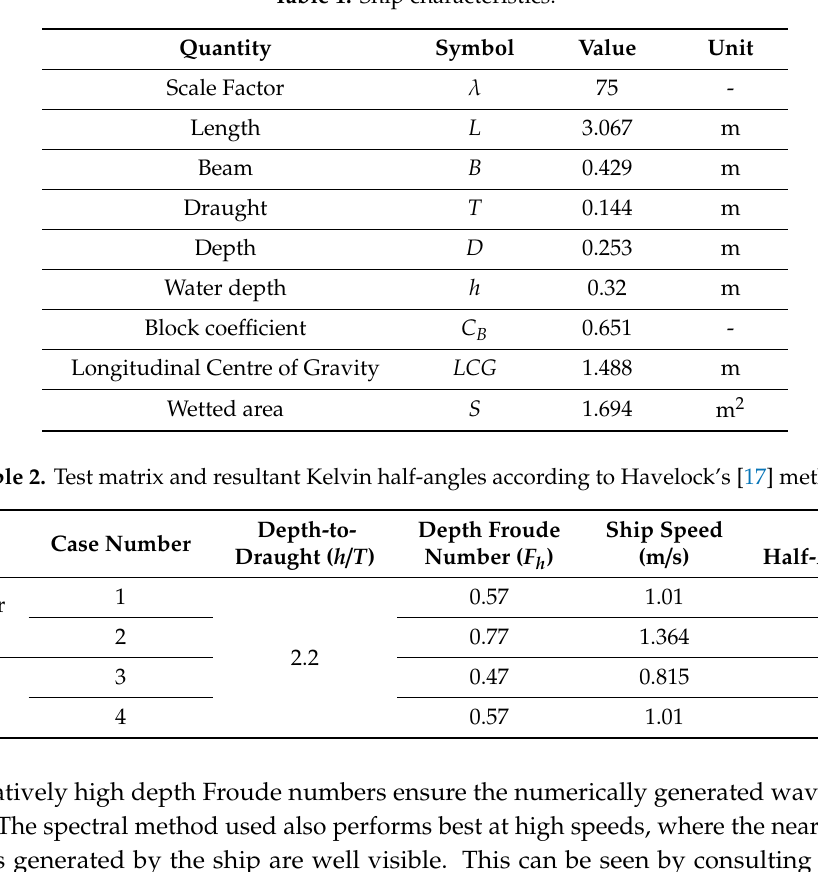
Table 1. Ship characteristics.